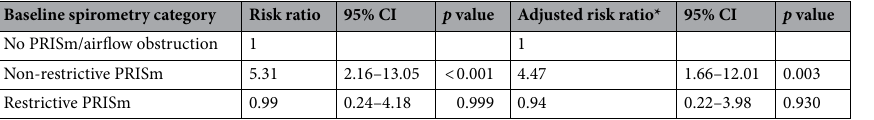
Table 3. Risk ratio, adjusted risk ratio, and 95% confidence interval (CI) for development of airflow obstruction in 5 years. BMI body mass index; PRISm preserved ratio impaired spirometry. *Risk ratio was adjusted for age, sex, BMI, and